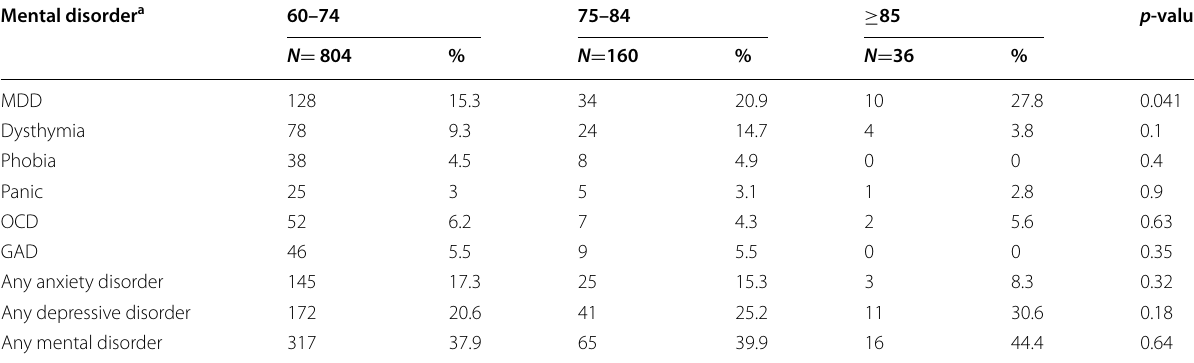
a Some participants had more than one disorder. Therefore, the total number of disorders was more than the total number of participants